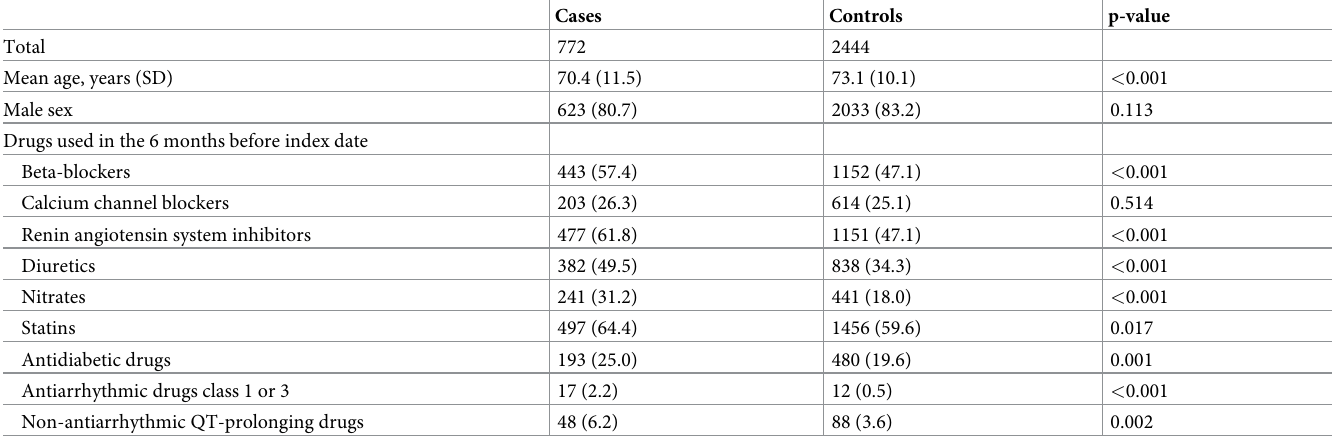
Table 1. Baseline characteristics of cases and